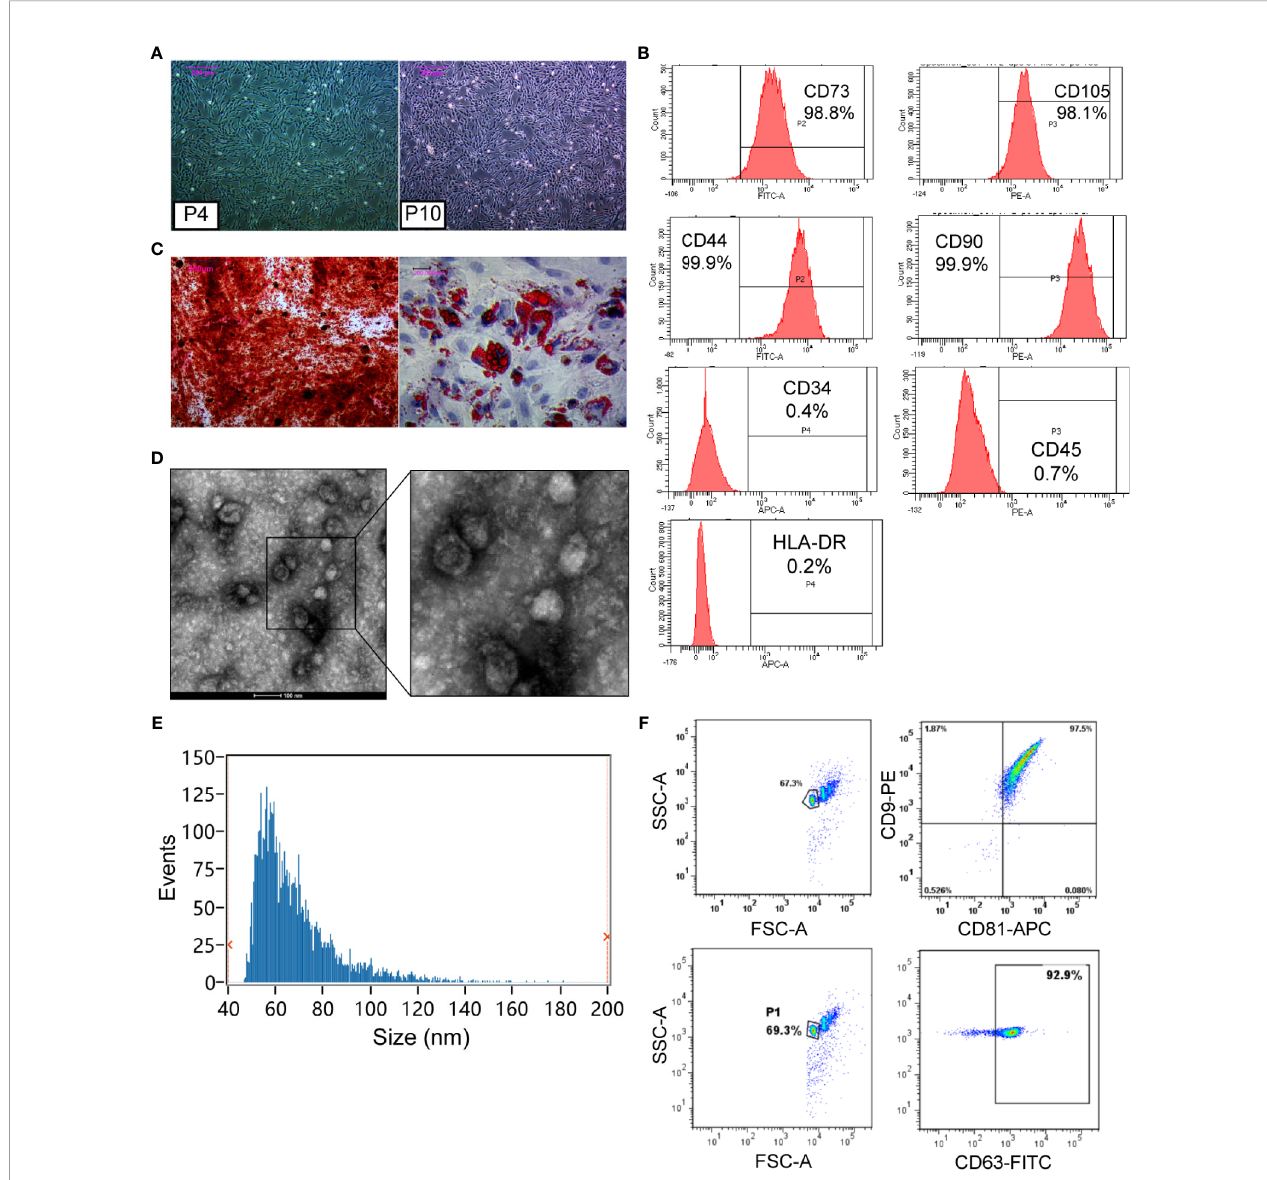
FIGURE 1 | Characterization and identi fi cation of hUCMSCs and hUCMSC-Exos. (A) The morphology of hUCMSCs at the fourth passage and the tenth passage. Scale bar: 200 m m. (B) hUCMSCs were positive for CD73, CD105, CD44, and CD90, and were negative for CD34, CD45, and HLA-DR, as shown by fl ow cytometry analysis. (C) Alizarin Red staining was used for hUCMSCs osteogenic identi fi cation, and Oil Red O staining was conducted for adipogenic differentiation. Scale bar: 200 m m. (D) Representative images of hUCMSC-Exos under transmission electron microscopy. Scale bar: 100 nm. (E) Particle size distribution of hUCMSC-Exos was determined by Flow Nano Analyzer. (F) hUCMSC-Exos were positive for CD9, CD81, and CD63, which were shown by fl ow cytometry